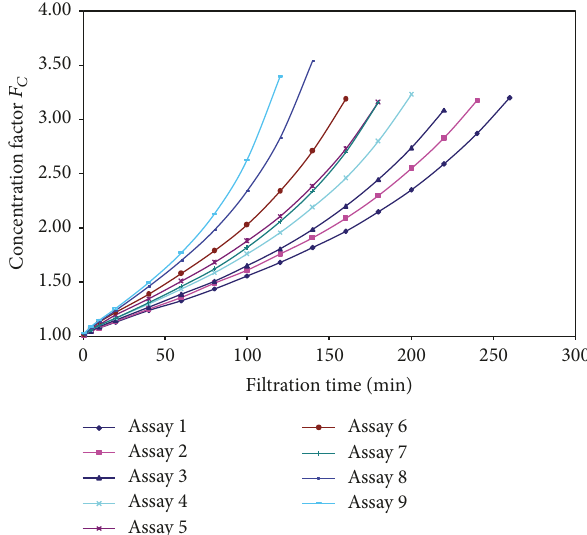
Figure 1: Variation of average concentration factor during nanofil- tration